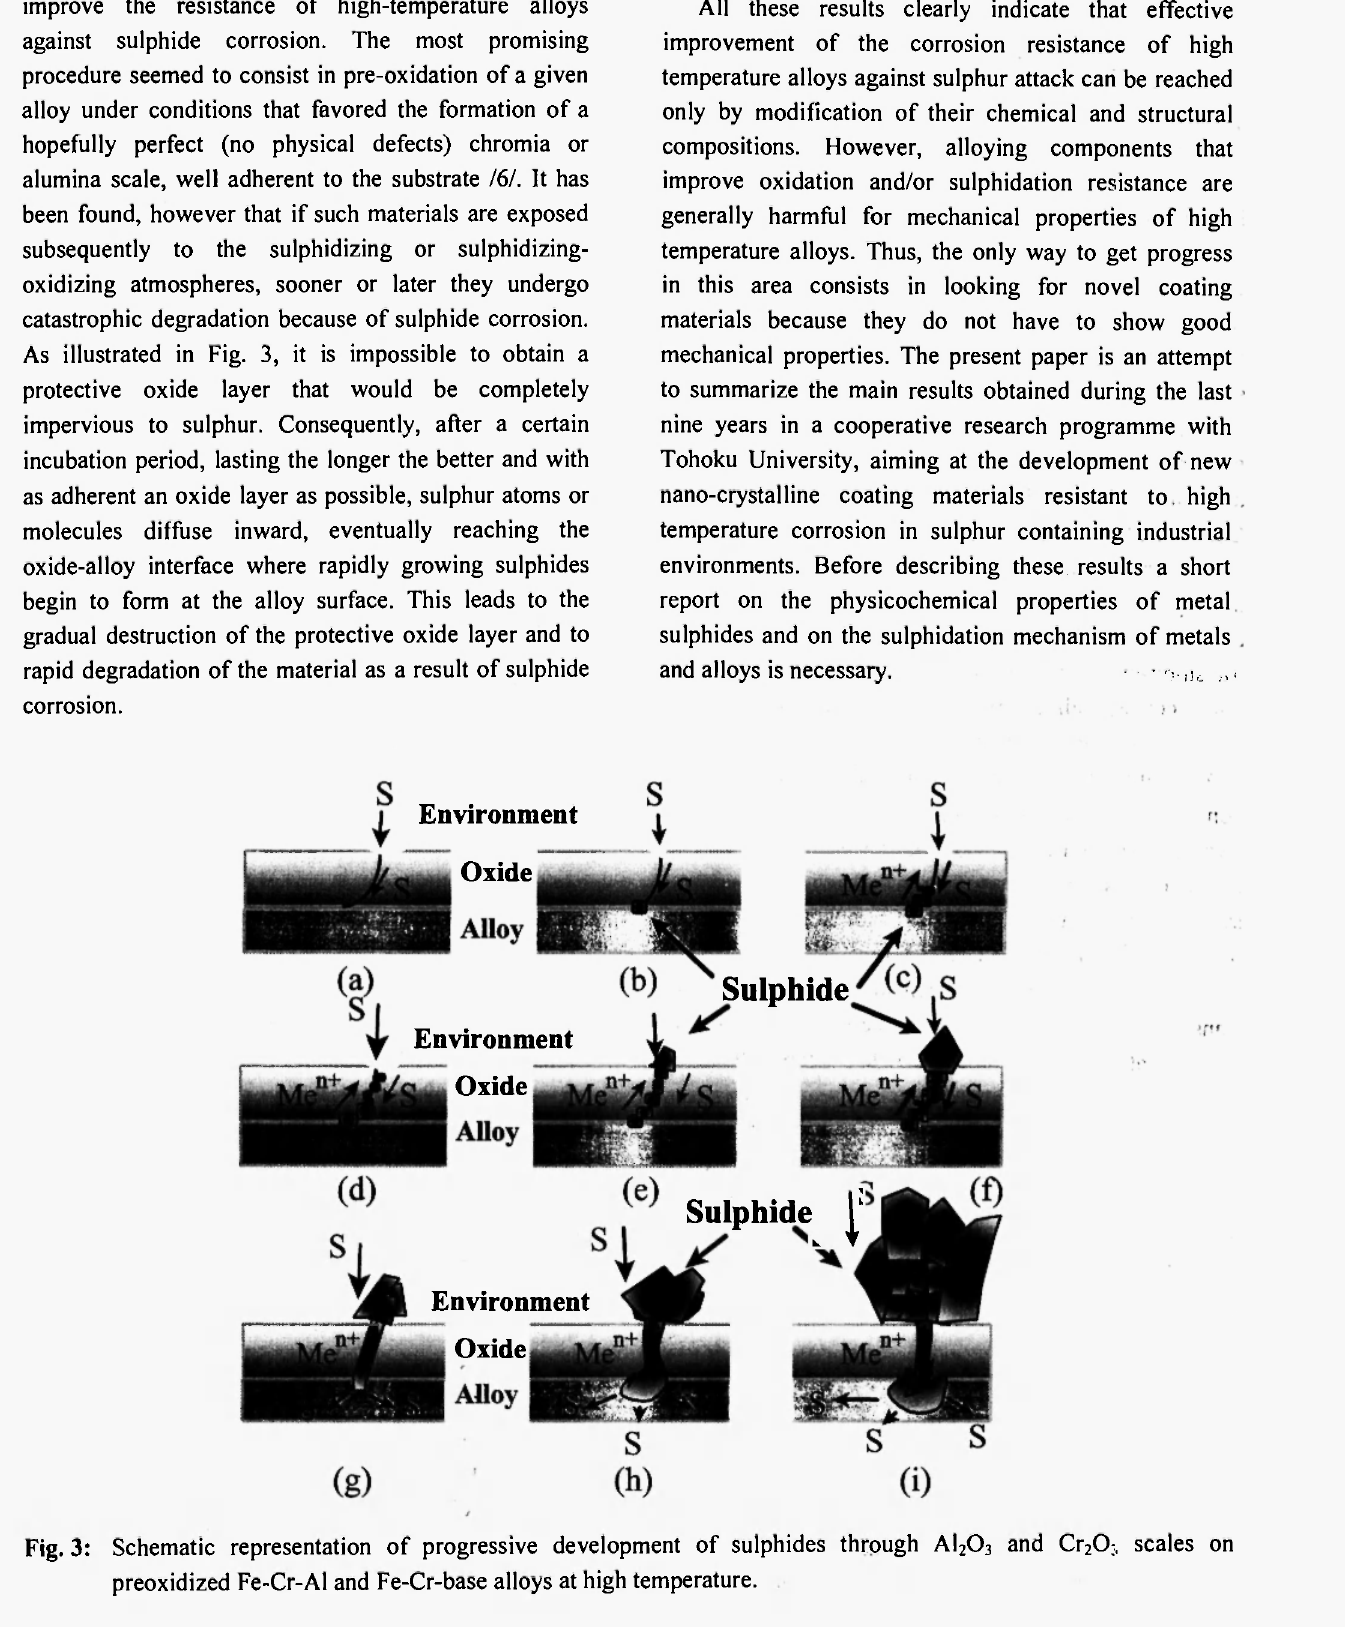
Fig. 3: Schematic representation of progressive development of sulphides through A1 2 0 3 and Cr 2 0 ; , scales on preoxidized Fe-Cr-Al and Fe-Cr-base alloys at high